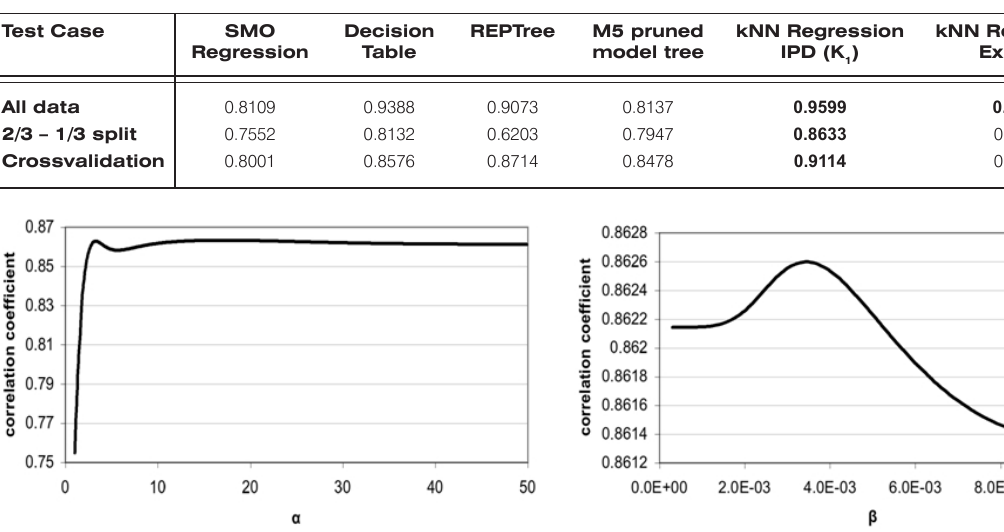
Figure 9. The correlation coefficient for the test set as a function of β